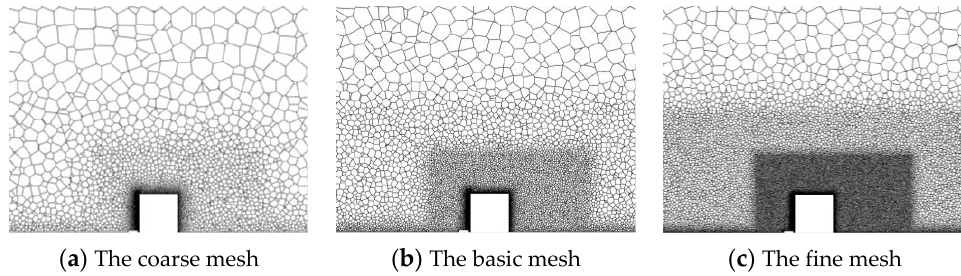
Figure 4. Grids for the simulation.